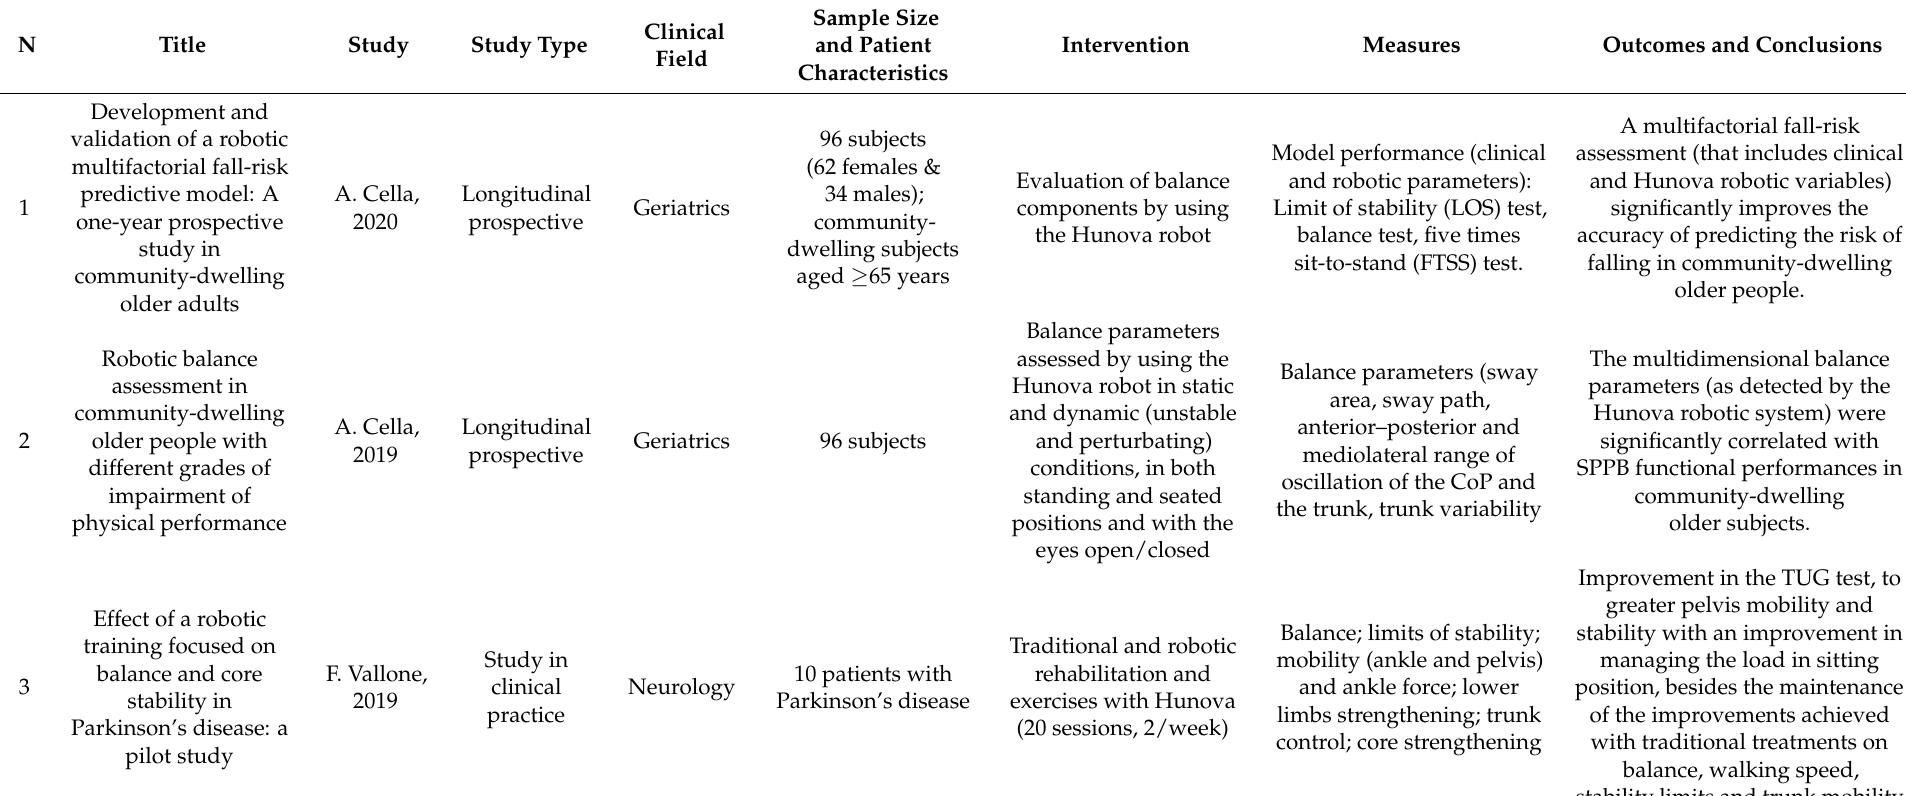
Table 1. Characteristics of included studies evaluated the effectiveness of Platform-based